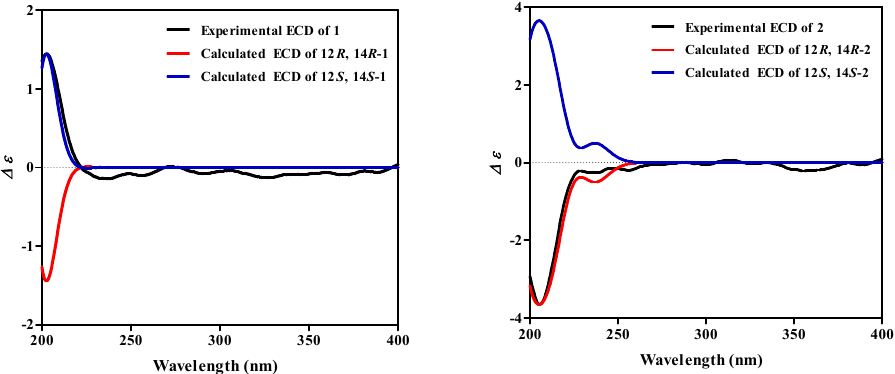
Figure 3. Calculated and experimental ECD spectra of compounds 1 – 2.